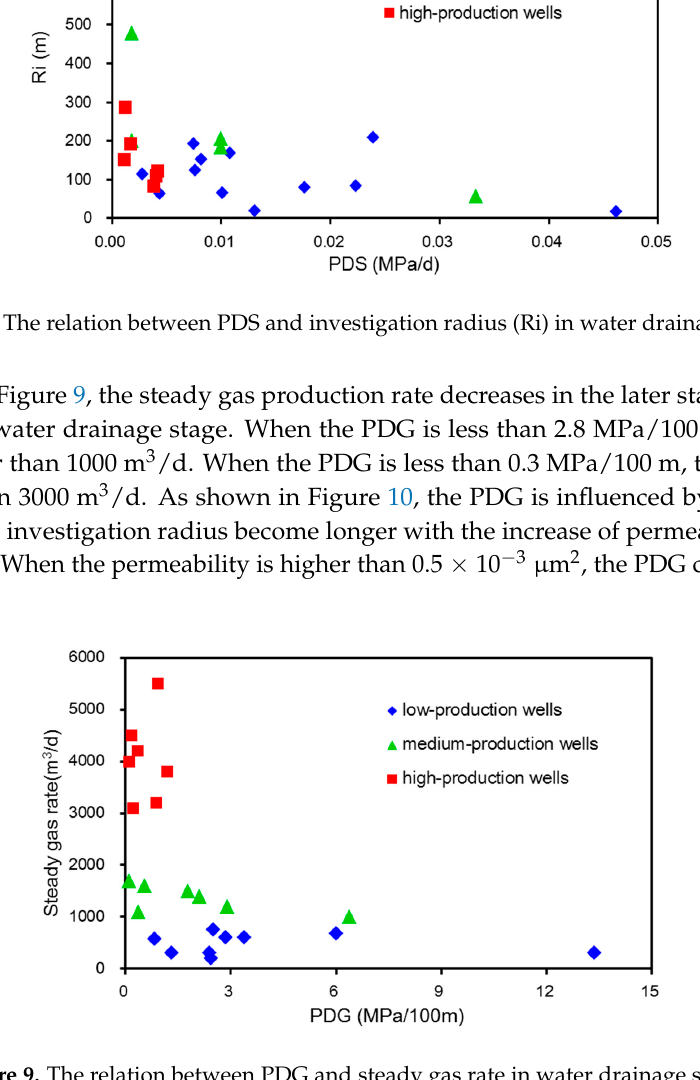
Figure 10. The relation between PDG and permeability in water drainage stage.